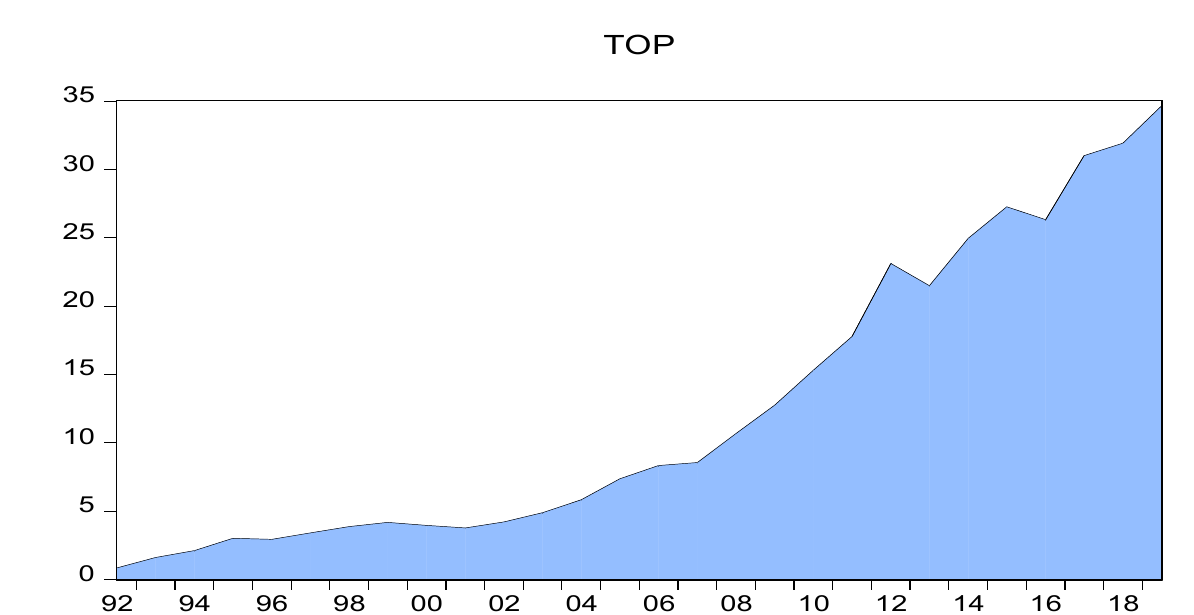
Figure 2. Trade openness movement in Ethiopia. Source: Constructed by authors using E-view 10.